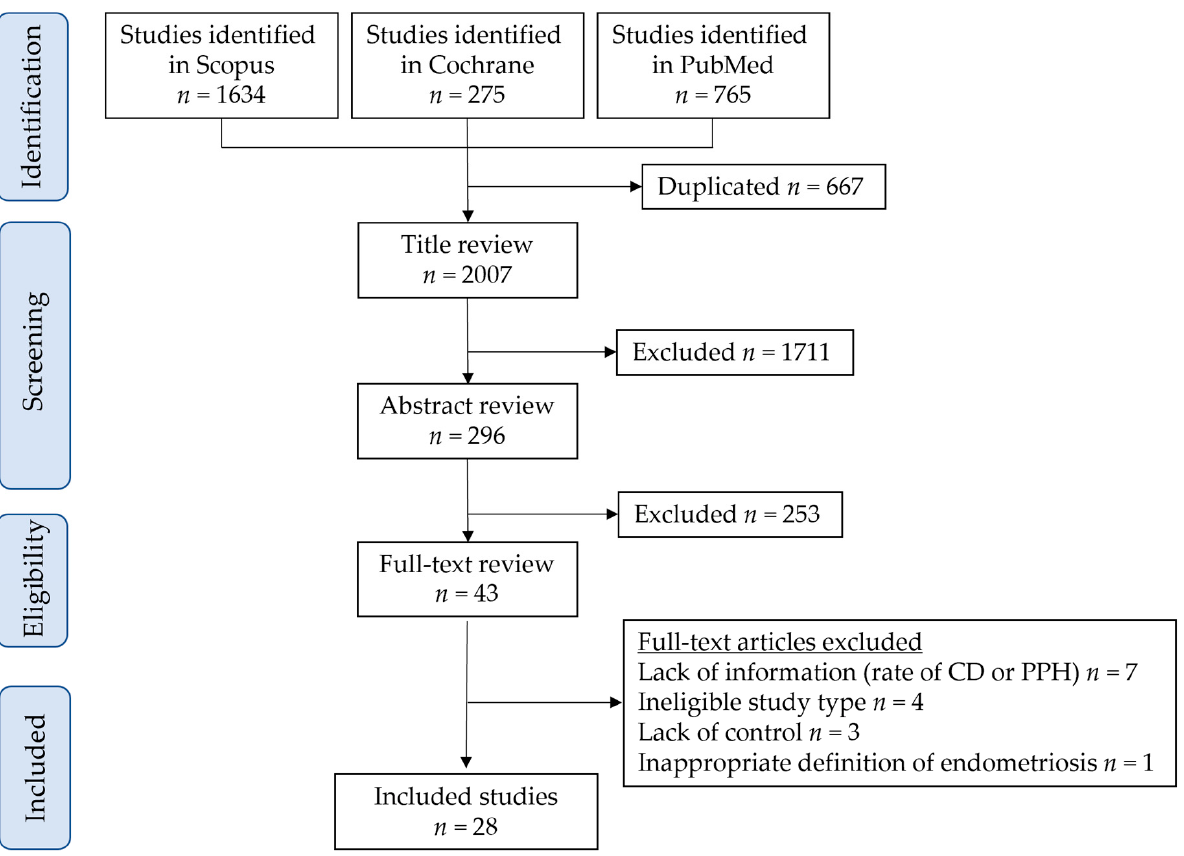
Figure 1. Study selection scheme for the systematic literature review. Abbreviations: CD, cesarean delivery; PPH, postpartum hemorrhage. Table 1. Comparator analysis of the rates of instrumental delivery between women with and without